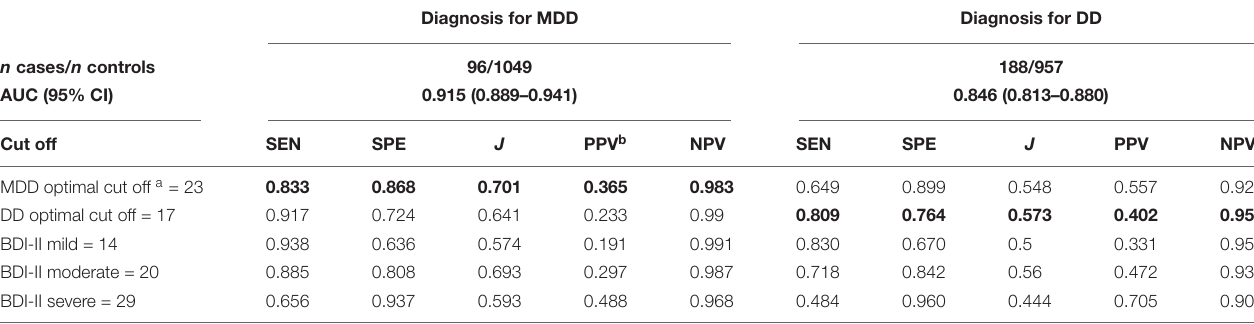
TABLE 5 | Results of ROC analyses for the MDD and DD.